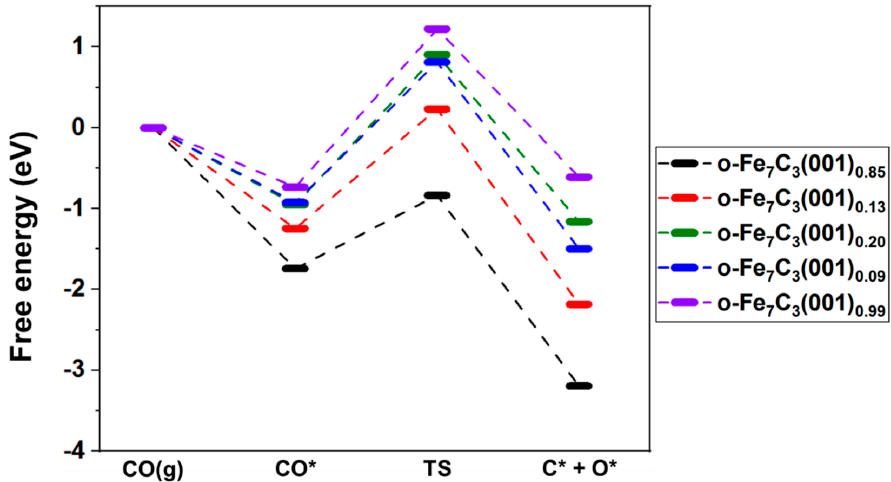
Figure 5. Free energy diagram for CO* dissociation pathways on o-Fe 7 C 3 (001) surfaces with different terminations. TS denotes the transition state. Table 2. Pre-exponential factors and reaction rate constants for CO* dissociation on o-Fe 7 C 3 (001) surfaces.